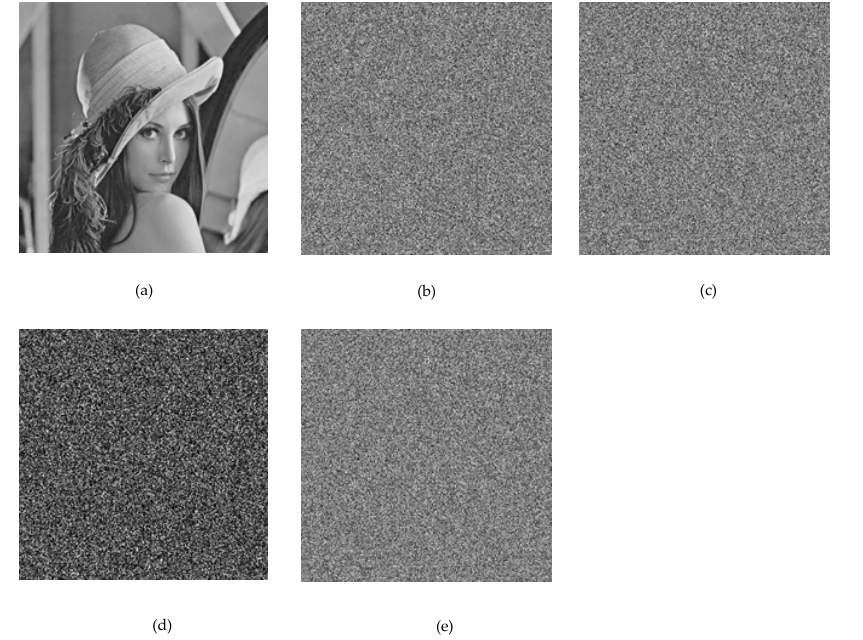
Figure 6. Encryption secret key sensitivity test: ( a ) ordinary image; ( b ) original key encrypted image; ( c ) modified key encrypted image; ( d ) differences between the two cipher-texts; ( e ) use the modified key to solve the cipher-text image encrypted by the original key.